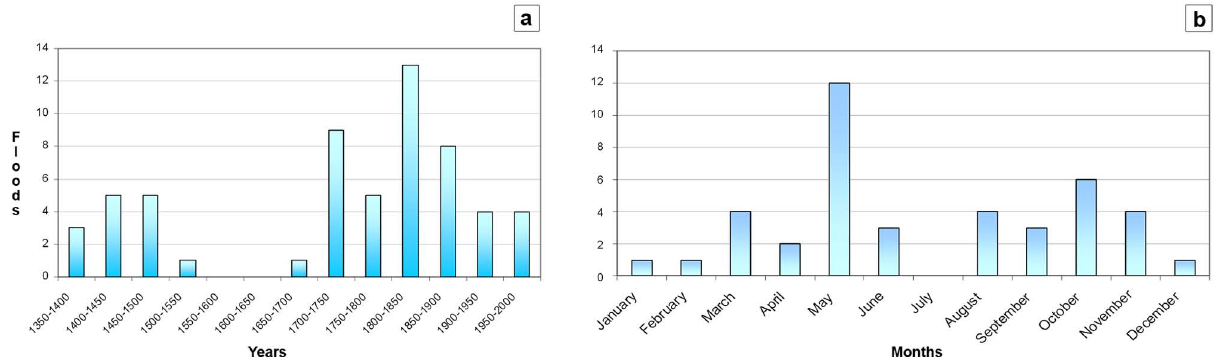
Fig. 6. Flood distribution in the area: (a) according to years (all floods collected) and (b) according to months (when the month is indicated in the source).